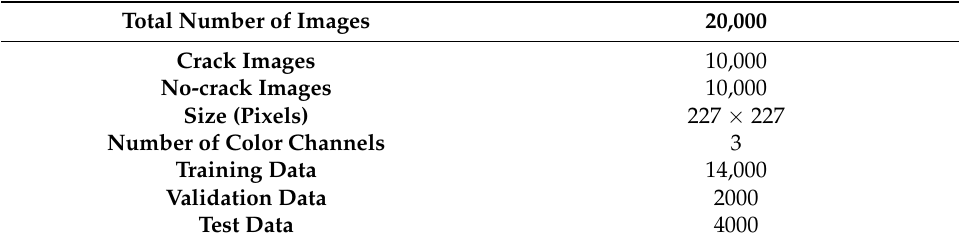
Table 2. Cross-image datasets.